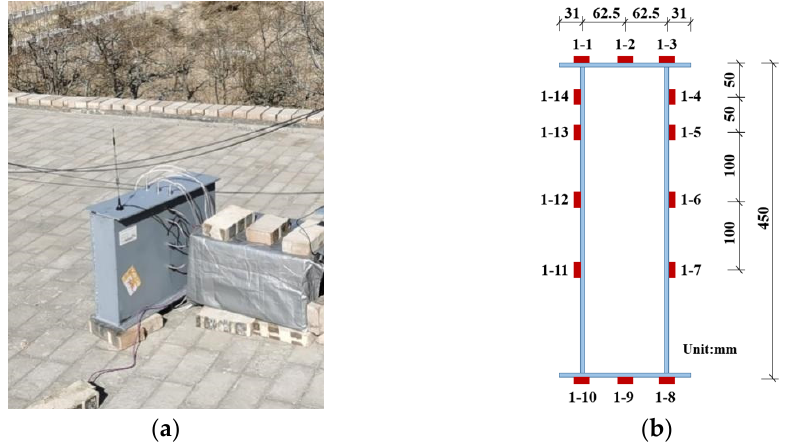
Figure 2. The experimental steel beam and the sensors. ( a ) The experimental steel beam; ( b ) the sensors.